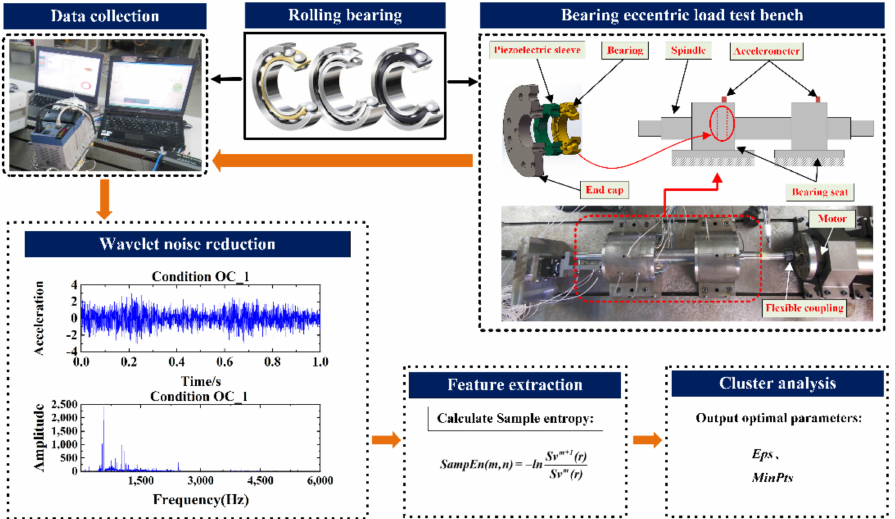
Figure 3. Feature extraction and state classification flow